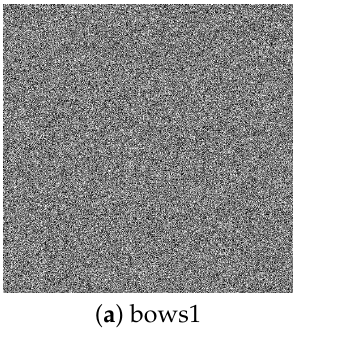
Figure 8. Marked encrypted